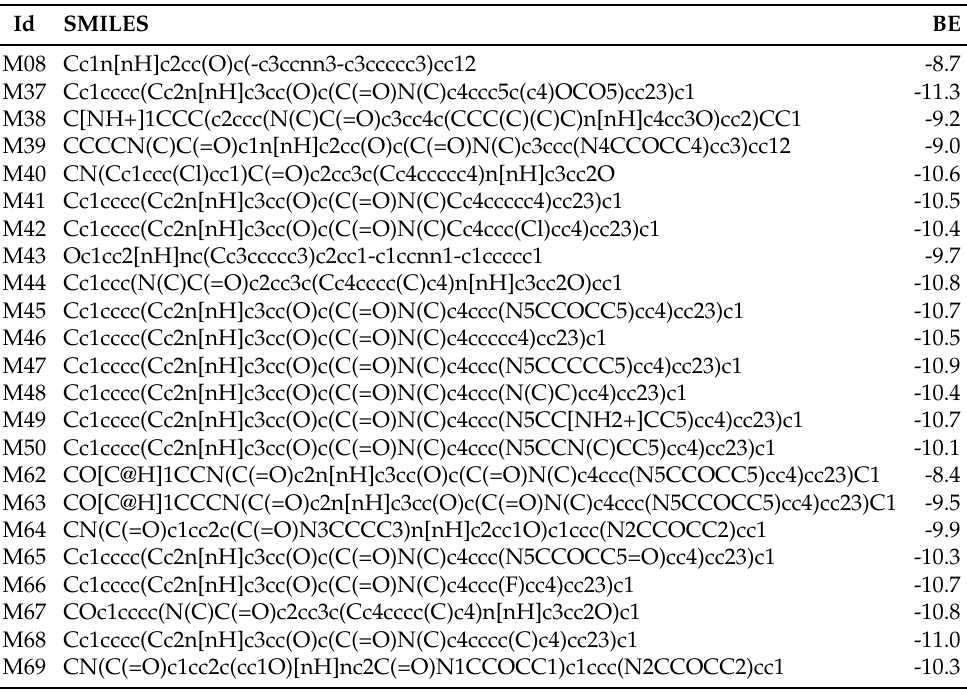
Table 2. Hsp90 inhibitors: hydroxy-indazole [25].